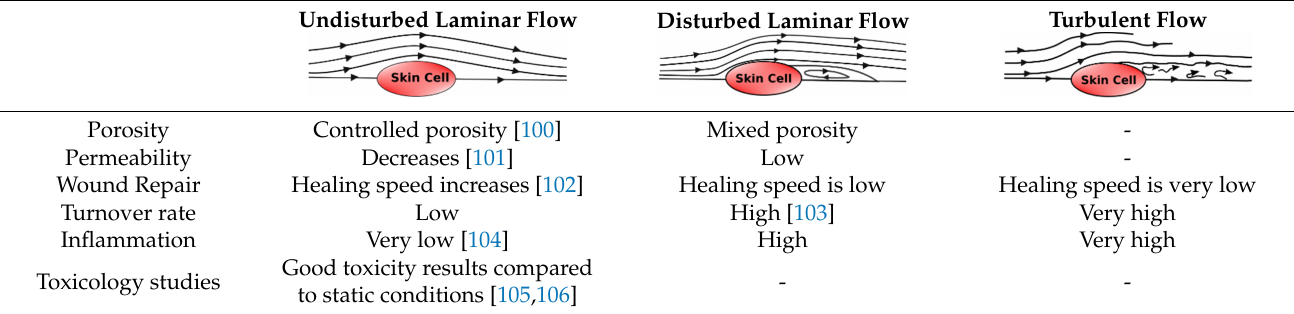
Table 7. Effect of associated shear stress on the skin cells in a microfluidic chip.